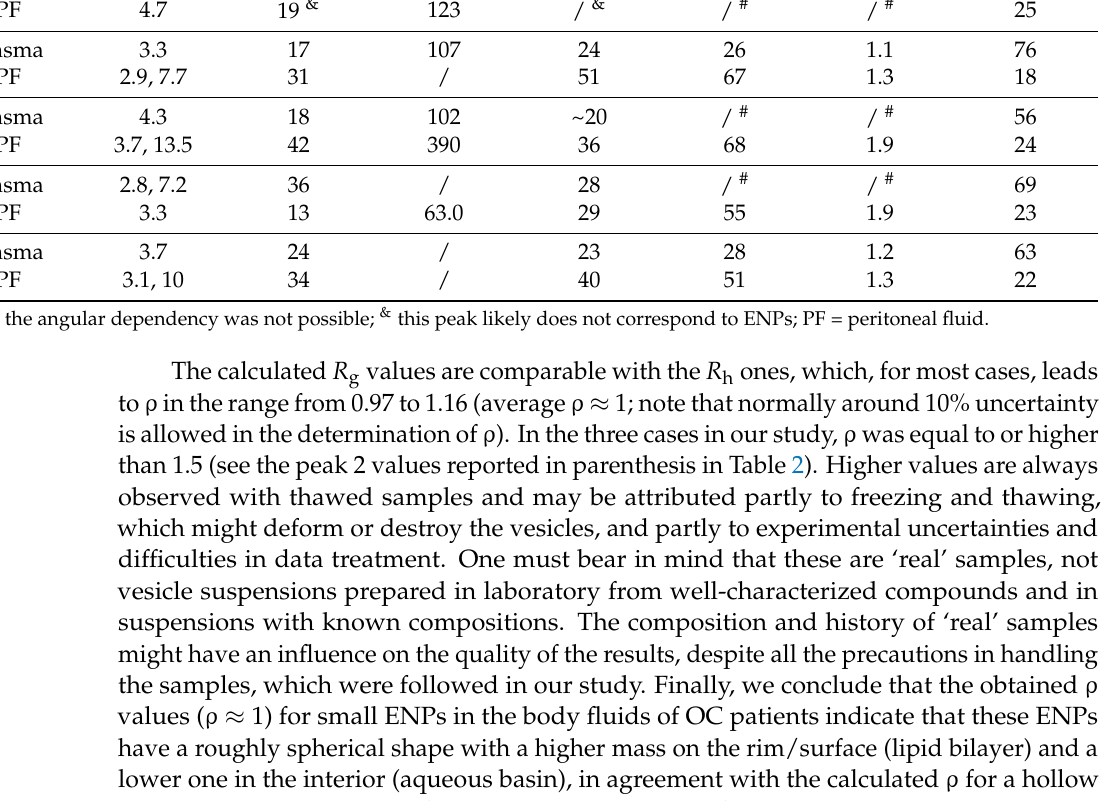
Table 3. Structural data for ENPs (represented by peak 2) determined by dynamic (DLS) and static light scattering (SLS) measurements for patients with benign ovarian cysts (BP-BOC): the mean hydrodynamic radius for peaks in the size distributions at an angle θ = 90 ◦ ( R h,90 ), the hydrodynamic radius extrapolated to θ = 0 ◦ ( R h,0 ), the radius of gyration ( R g ), the shape parameter ρ (= R g / R h ) , and the contribution of peak 2 particles to the total scattering intensity at θ = 90 ◦ ( I tot,90 ). R h,90 /nm Angular Dependency (Peak 2)